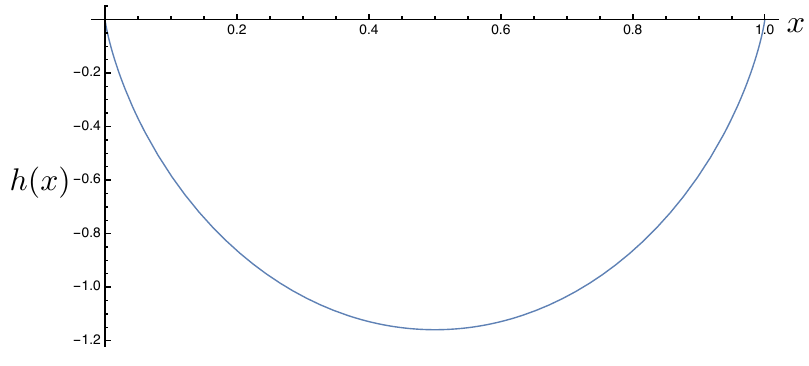
Figure 5 . The integral kernel h ( x ) for (cid:1) = 1 = 2, given by equation